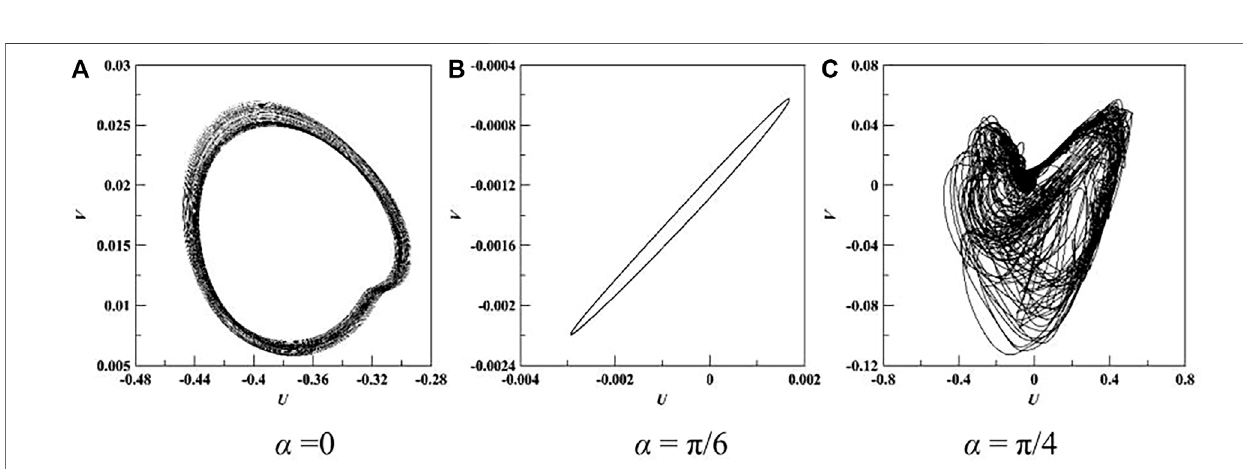
Frontiers in Energy Research |